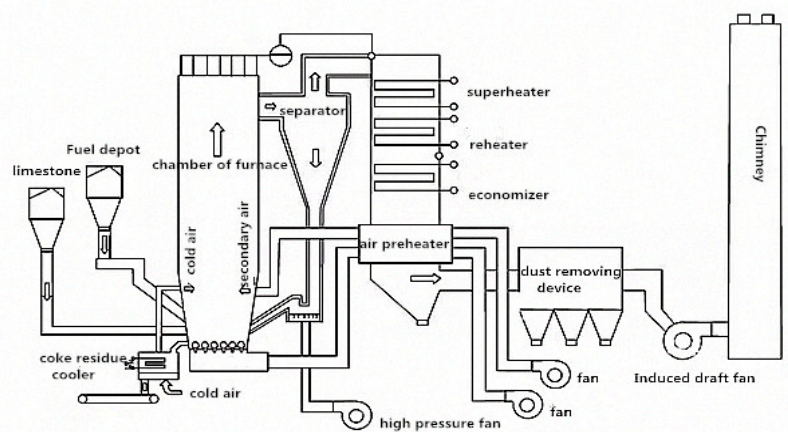
Figure 2. Schematic diagram of circulating fluidized bed combustion technology (CFB). (Source: ZHENGGUO VESSEL CO. LTD.).